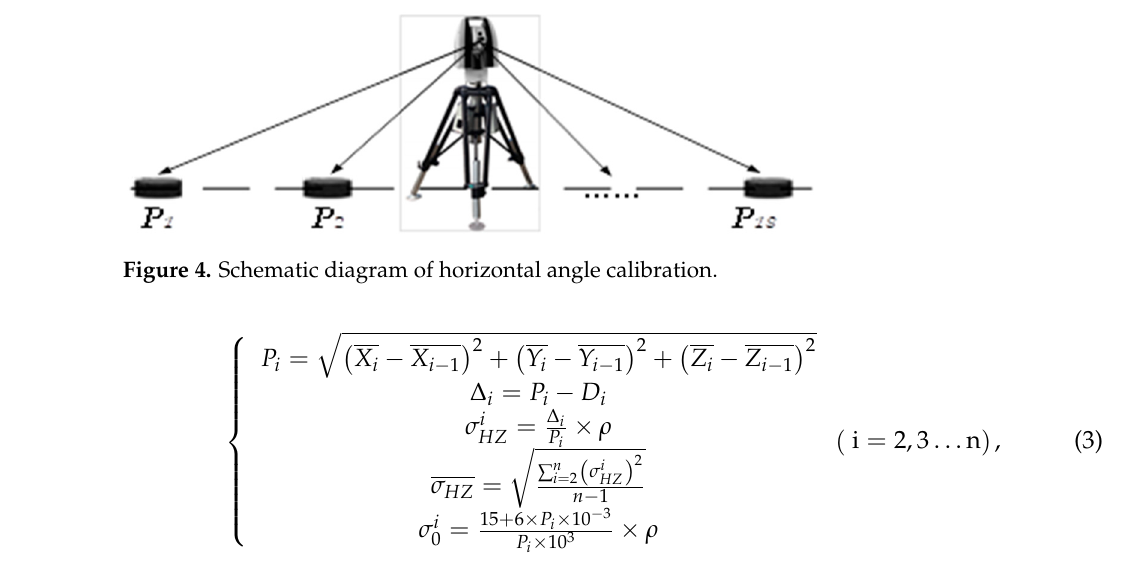
Figure 4. Schematic diagram of horizontal angle calibration.